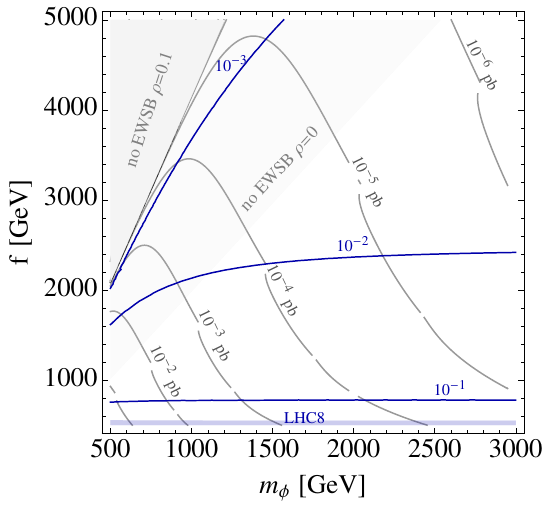
Figure 12 . Rates for the Fraternal Twin Higgs production cross section times branching ratio into long-lived glueballs as a function of the Twin Higgs mass, m (cid:30) , and f . In (light) gray, we show the region that cannot produce successful EWSB for (cid:26) = 0 : 1 ( (cid:26) = 0). The blue shaded region at low values of f is probed by 8 TeV Higgs coupling measurements. The solid blue lines indicate values of sin 2 (cid:18) using